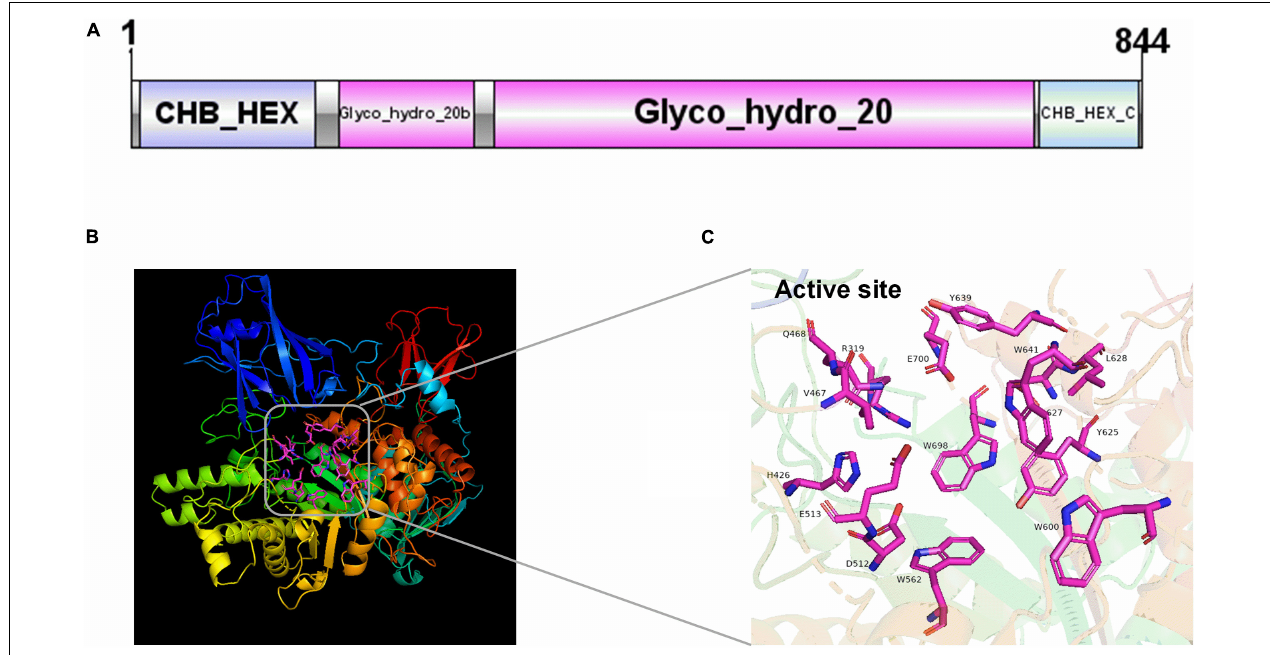
FIGURE 1 | The domain and structure prediction of NAGaseA. (A) The conserved domain of NAGaseA, the image was generated using IBS Illustrator (Liu et al., 2015). (B) The prediction of the 3D structure of NAGaseA, (C) the active sites of NAGaseA.